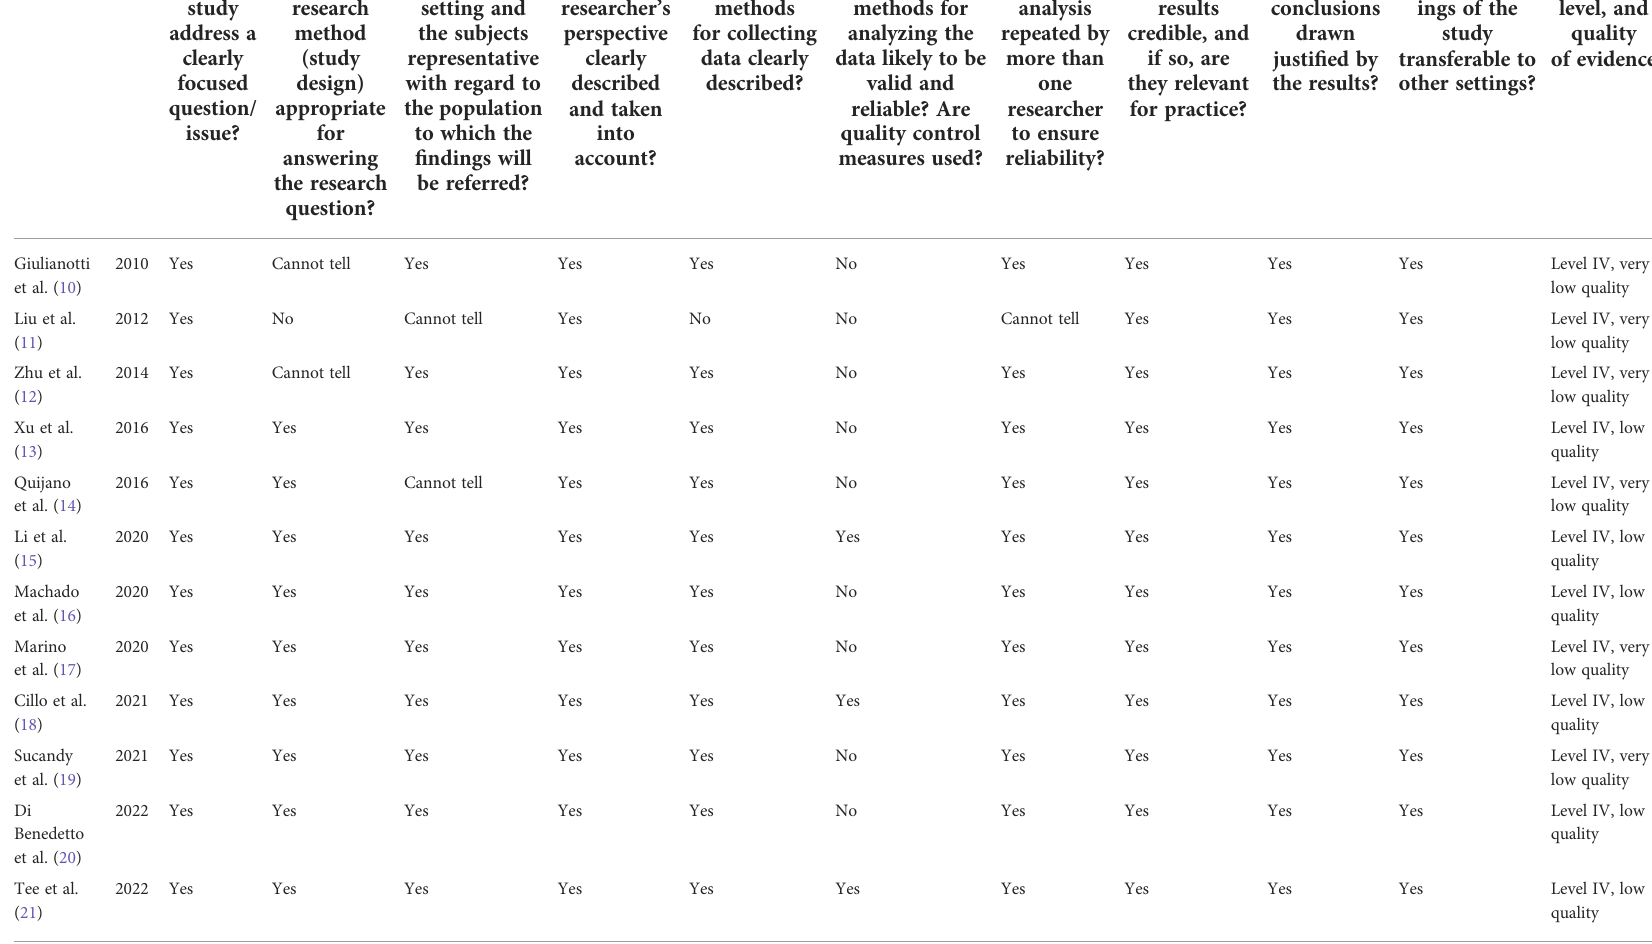
TABLE 3 Critical appraisal of the included studies based on the Critical Appraisal tool of the Center for Evidence-Based Management-CENMa (9).